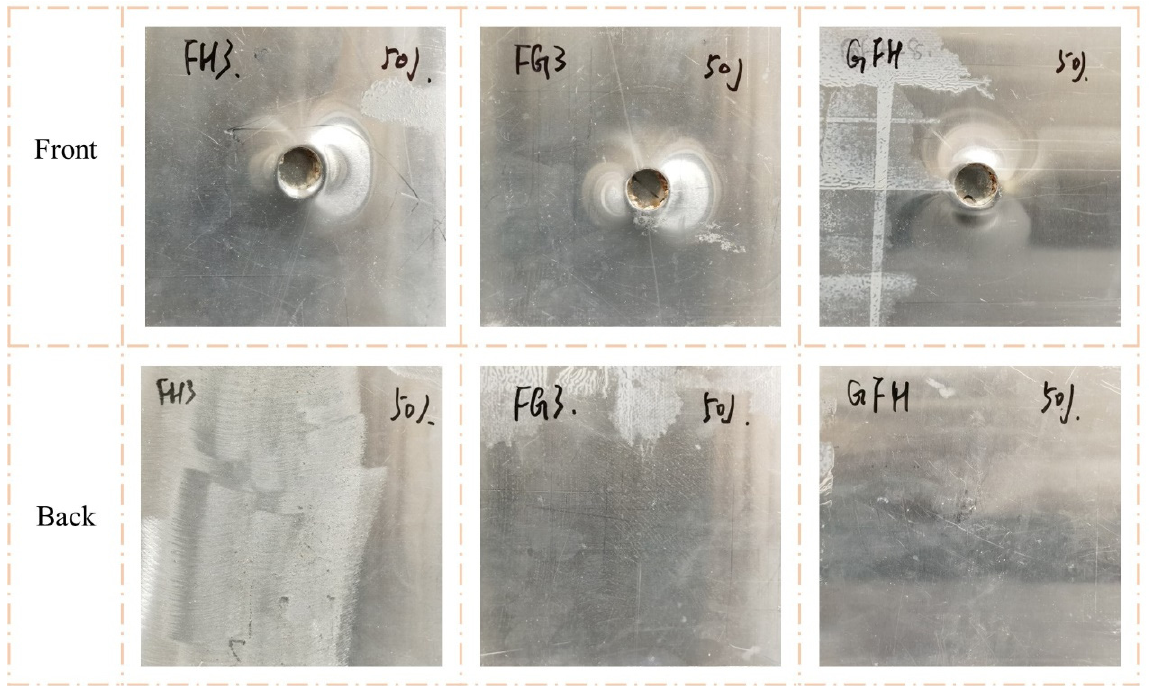
Figure 15. Damage modes of FH3, FG3, and GFH under 50 J impact energy with flat impactor.